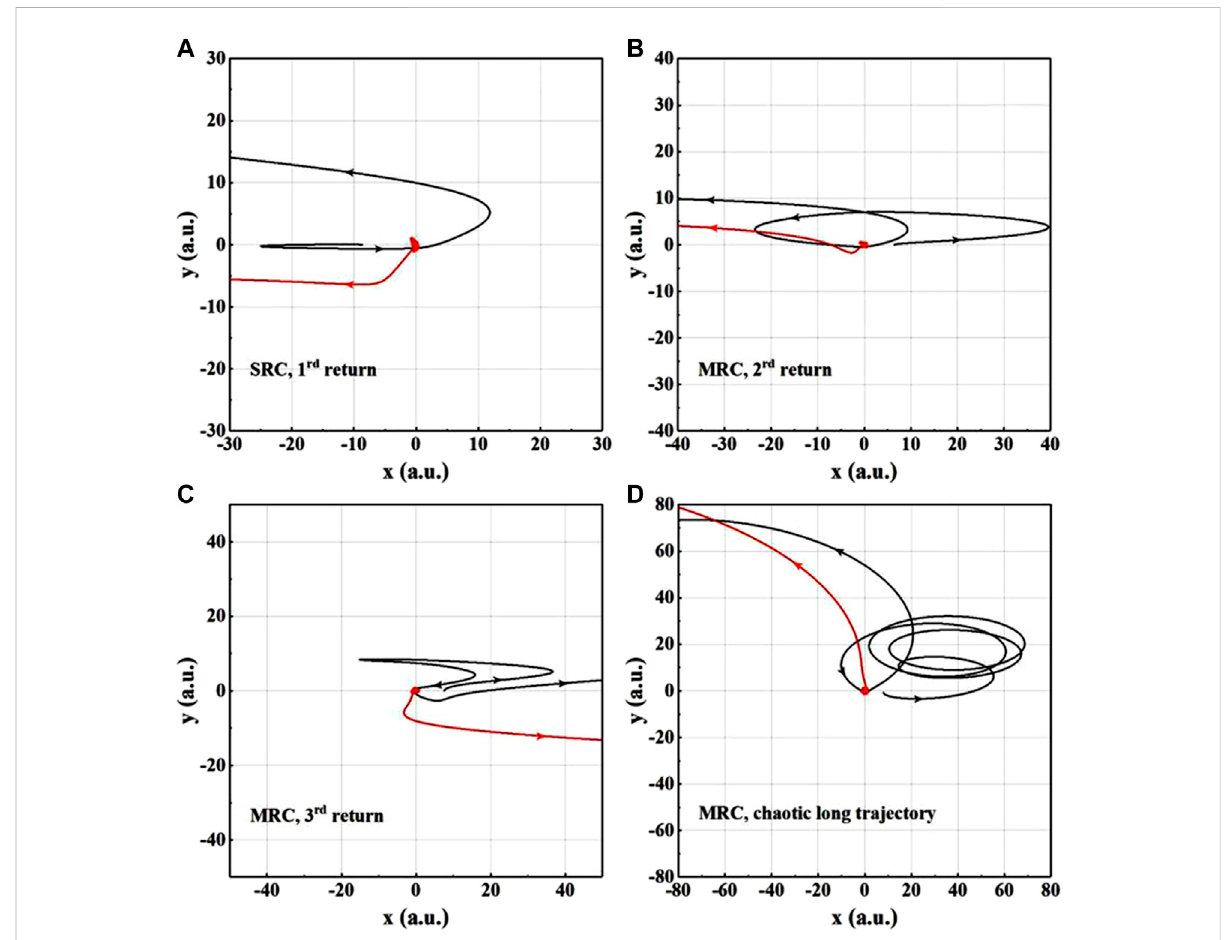
FIGURE 5 Ionized electrons return to collision trajectory for the fi rst time (A) , second times (B) , third times (C) and many times (D) ,